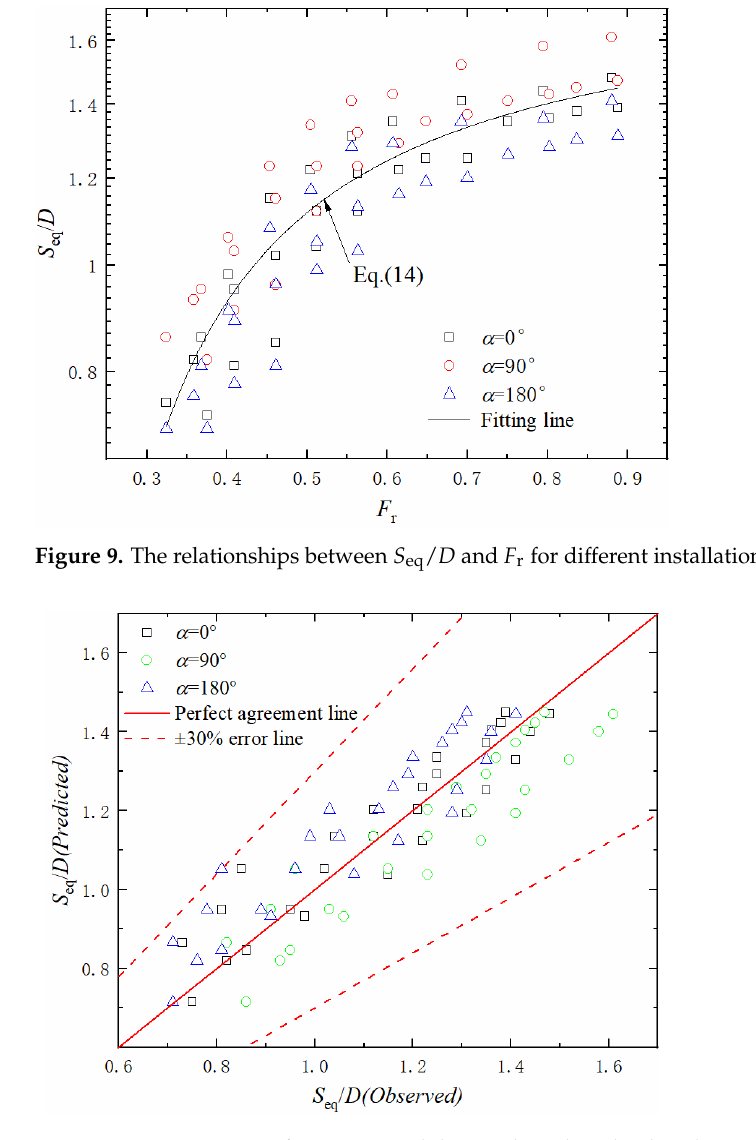
Figure 10. Comparison of experimental data and predicted values by Equation (14).